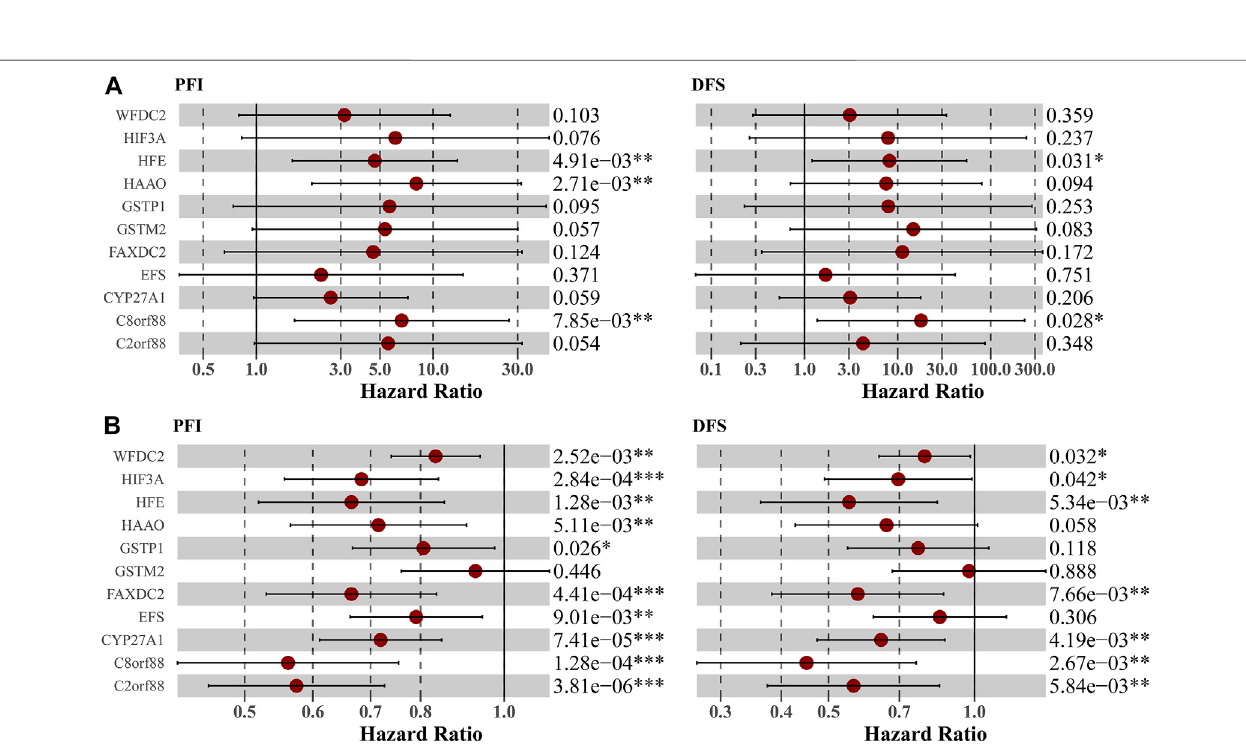
Frontiers in Cell and Developmental Biology |